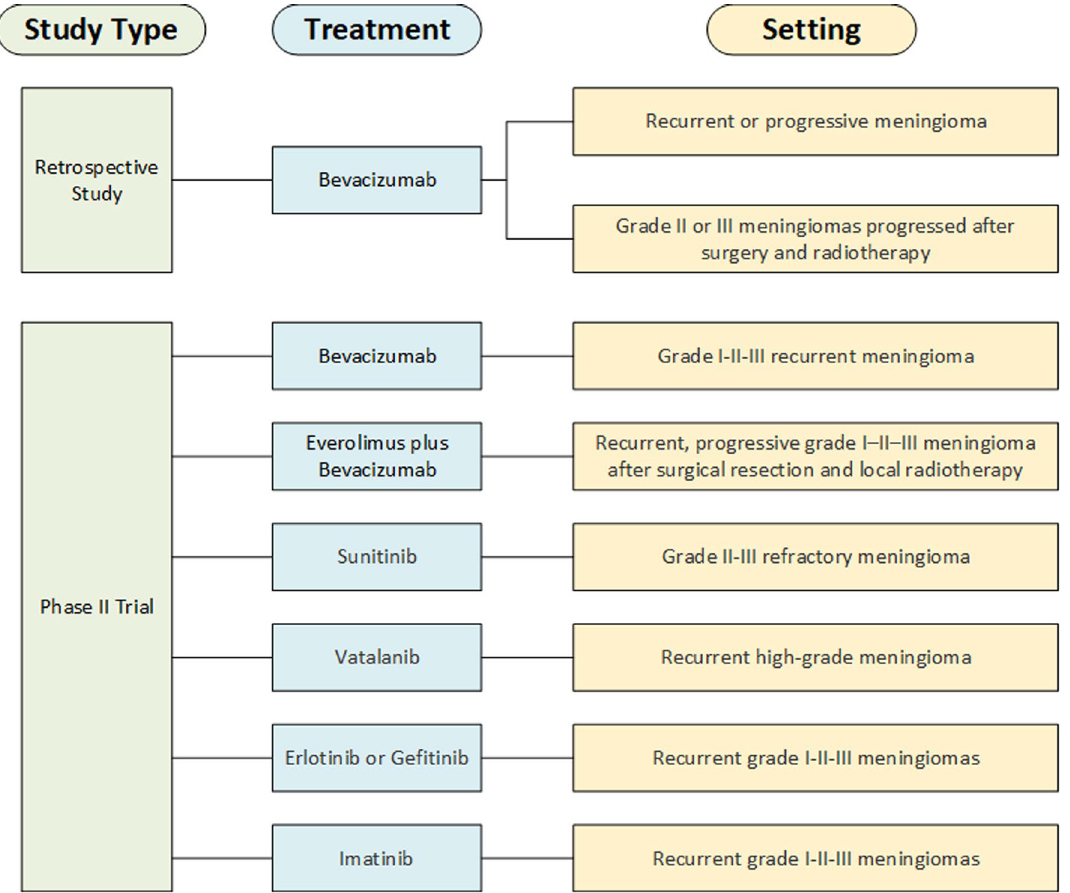
Fig. 4 Monoclonal Antibody Studies for Meningioma